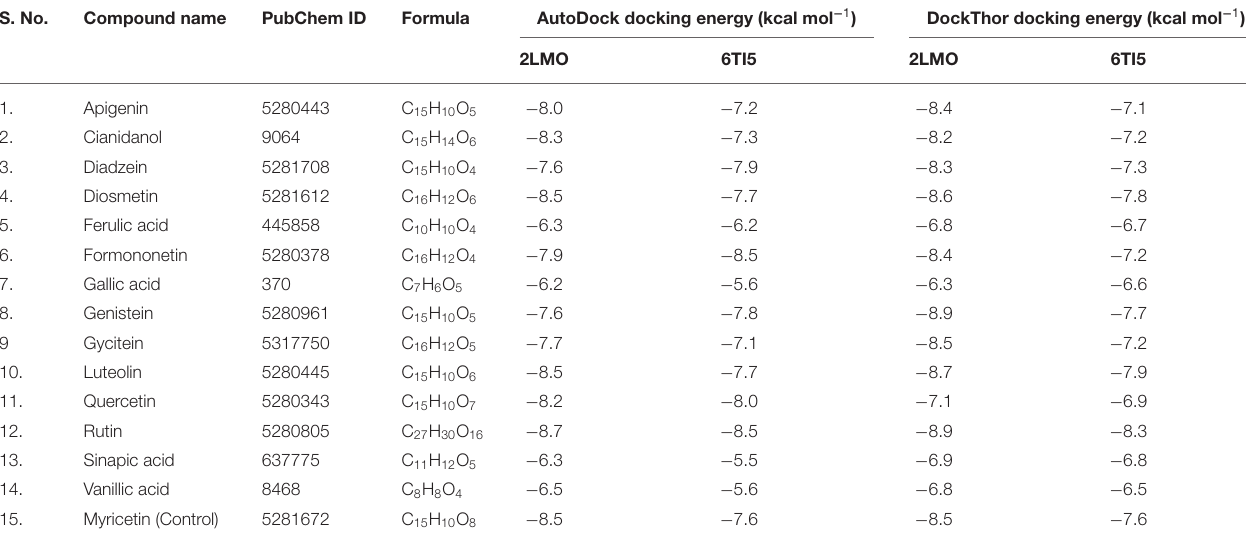
TABLE 1 | Molecular docking scores of selected palm date phytochemicals. S.